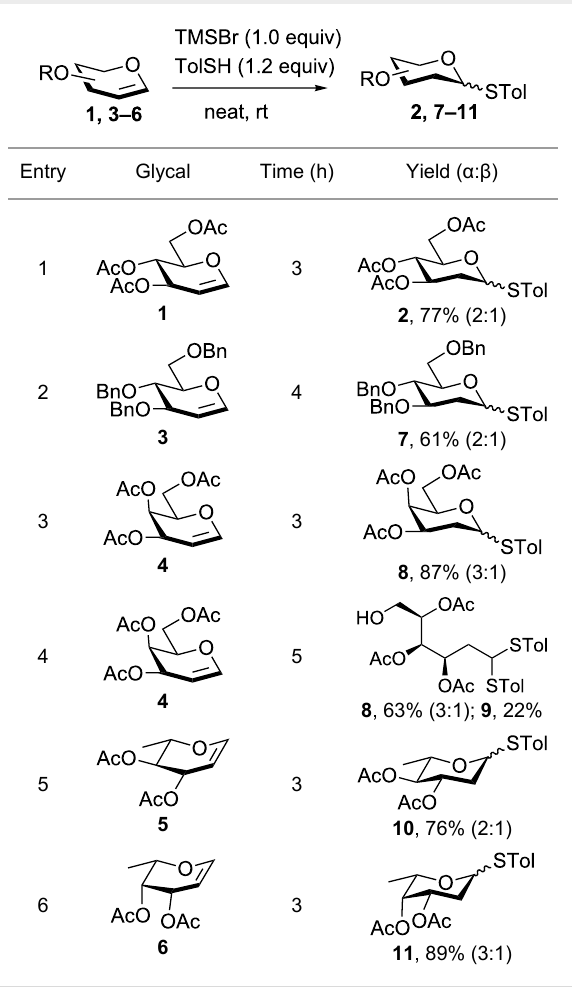
Table 1: TMSBr-mediated thio-addition of